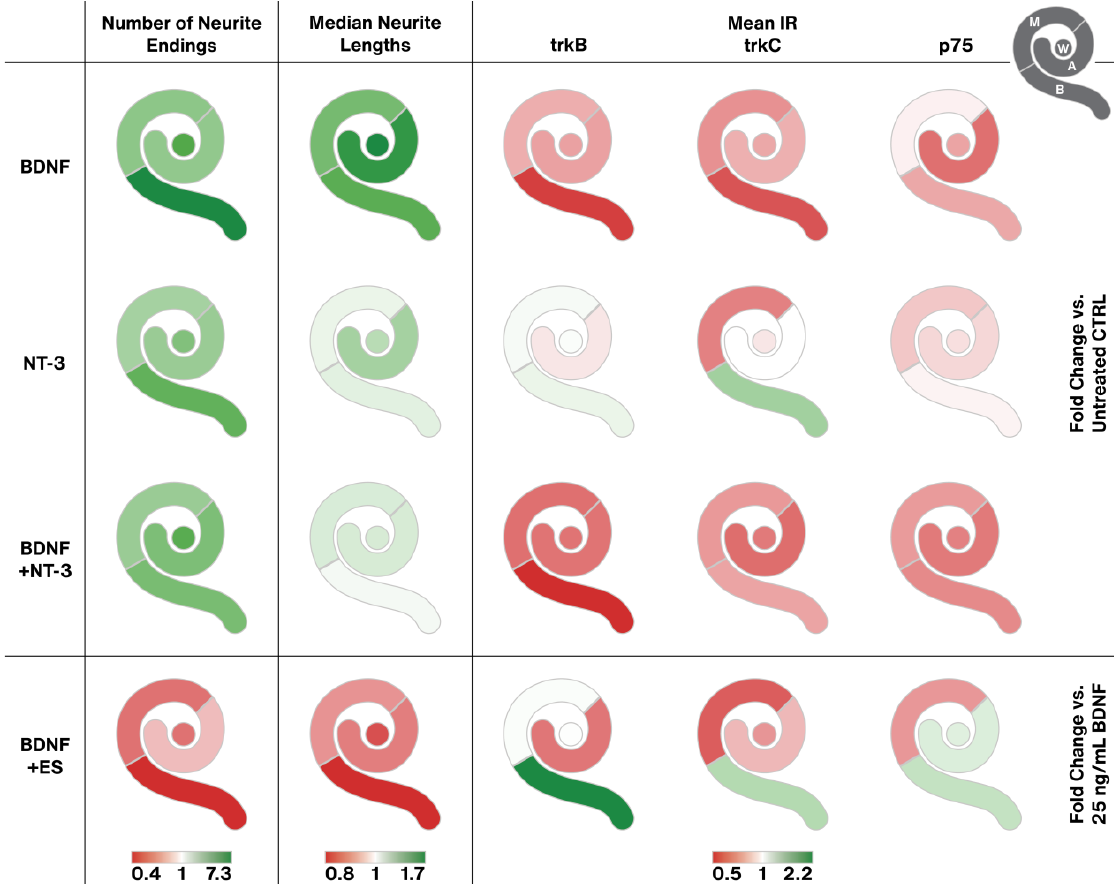
Figure 10. Graphical representation of the main results. Each cochlea pictogram is separated into four segments, representing apical (A), middle (M), and basal (B) explants, as well as the equally pooled, whole cochlea represented as a circle in the middle (W) (see pictogram in the upper right corner). The three gradients at the bottom determine the color range for the first, second, and last three columns, respectively. Each color visualizes the fold change of the median related to the me- dian of the respective untreated (first three rows) or 25 ng/mL BDNF treated (last row) groups. To minimize the influence of variation, the first two columns contain all equally pooled concentrations or stimulation patterns of each agent (BDNF, NT-3, BDNF + NT-3, or BDNF + ES). For the mean IR of the receptor quantification, only distinct treatments were available (25 ng/mL BDNF, 200 ng/mL NT-3, 25 ng/mL BDNF + 200 ng/mL NT-3, 25 ng/mL BDNF + 500 µA ES).